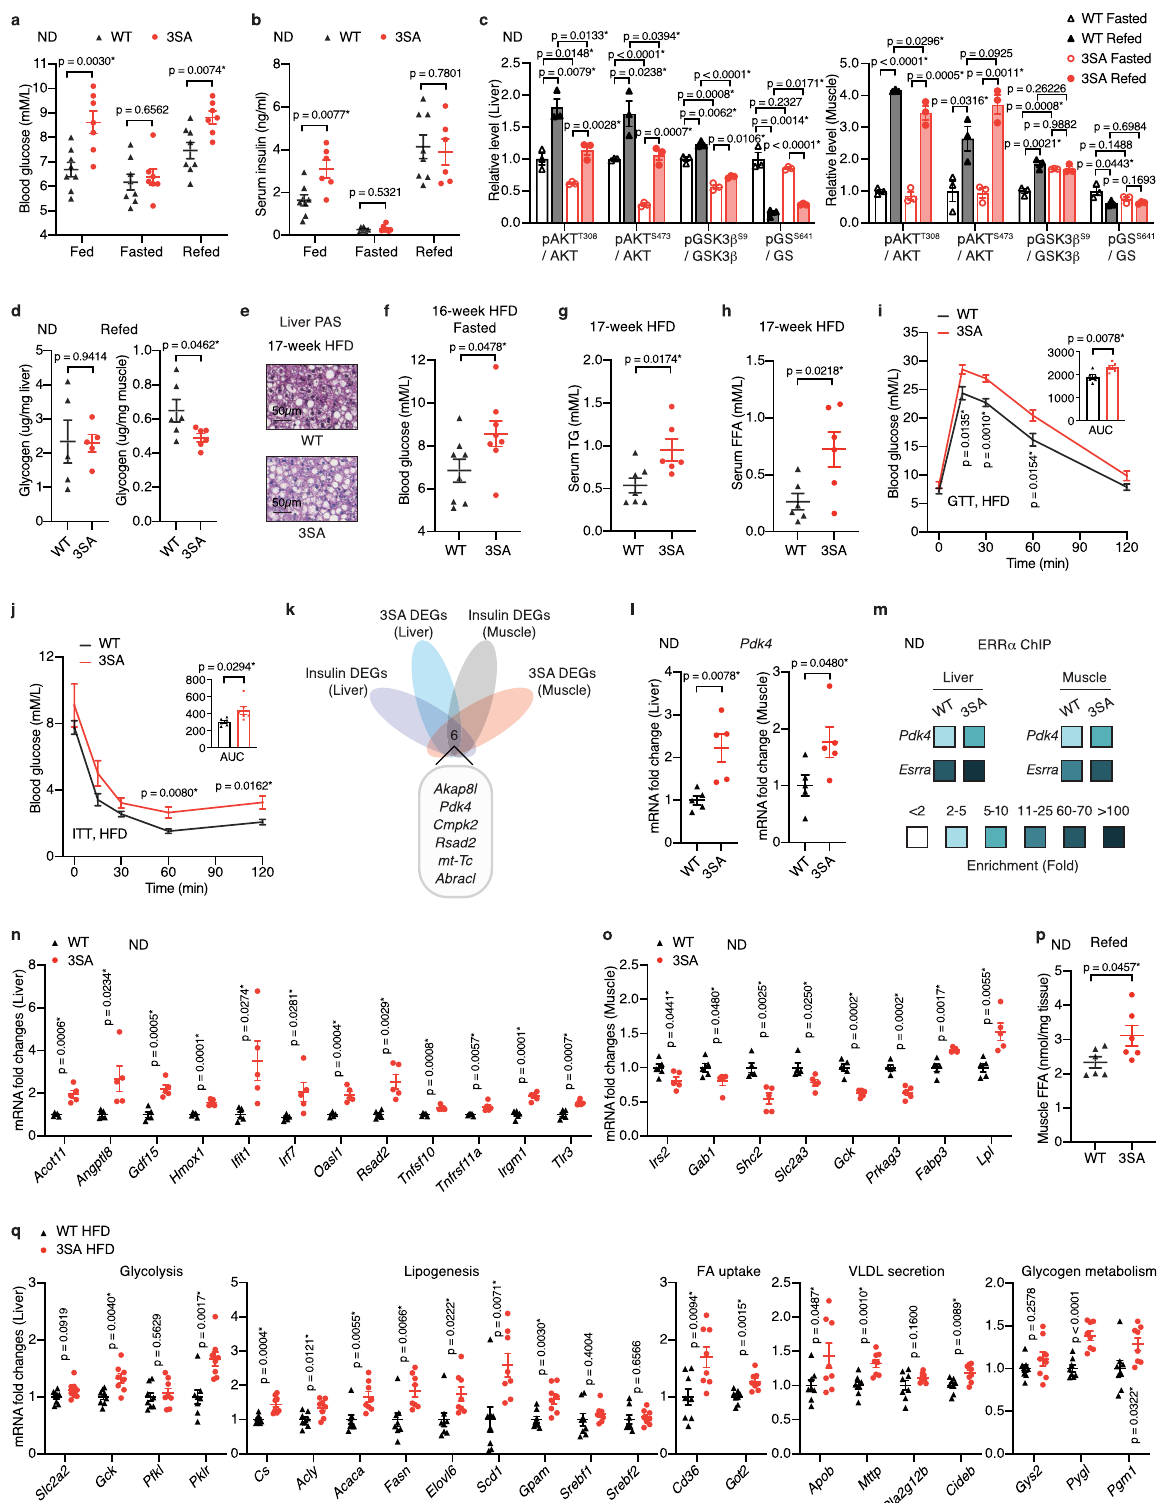
lipid-related genes ( Acot11 , Angptl8 ) and in fl ammation-related genes ( Gdf15 , Hmox1 , Rsad2 , Tnfsf10 , Tnfrsf11a , Irgm1, Tlr3 ) in ERR α 3SA liver (Supplementary Fig. 7p). Together, our results demonstrate that C29-mediated suppression of the stable and activated ERR α 3SA protein enhances whole-body insulin sensi- tivity as well as provides anti-obesity, anti-hyperglycemia/ insulinemia/triglyceridemia, and anti-hepatic steatosis effects in